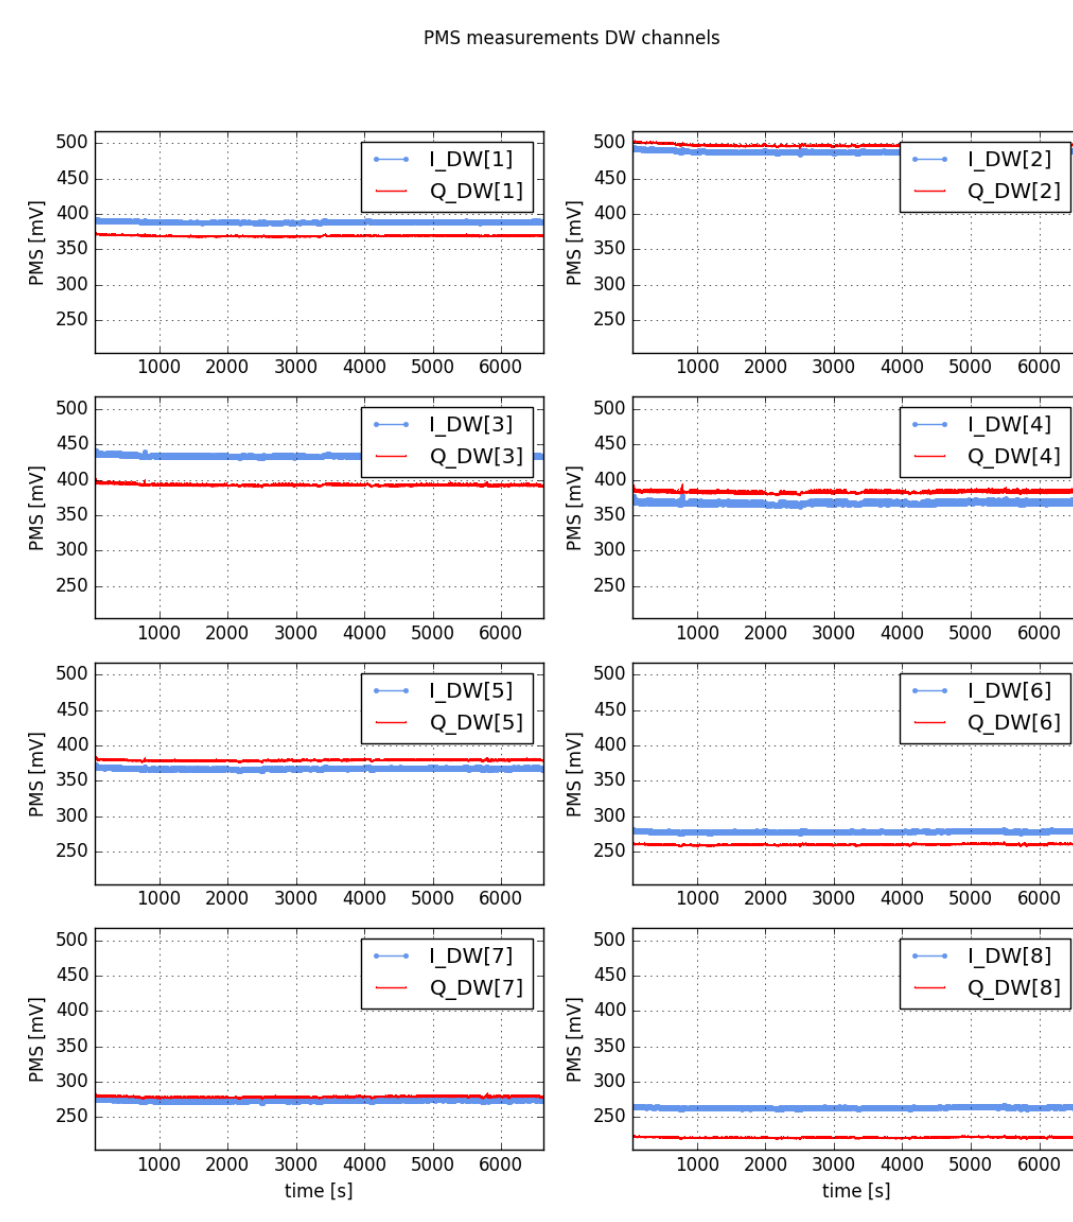
Figure 12. PMS values for the eight down-looking